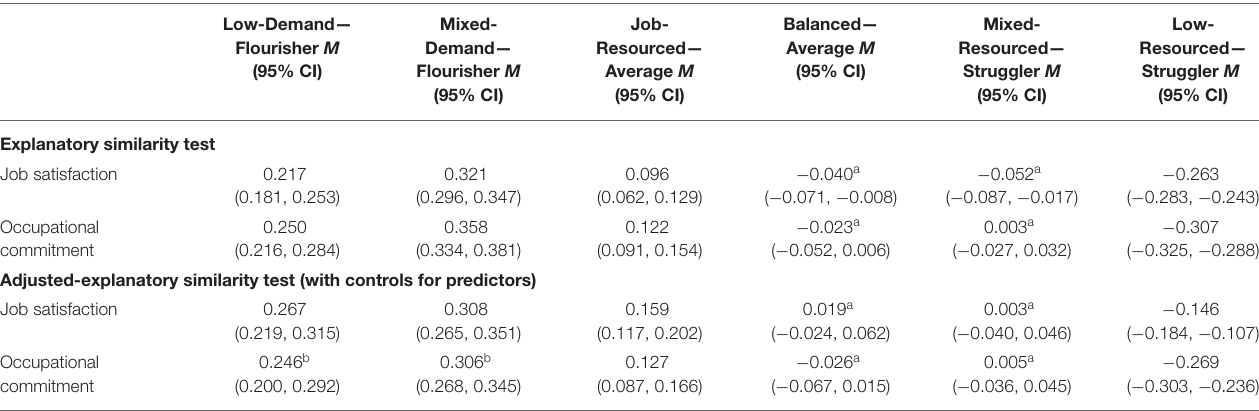
TABLE 5 | Means of teacher-level outcomes from explanatory similarity test and adjusted-explanatory similarity test (Single-level